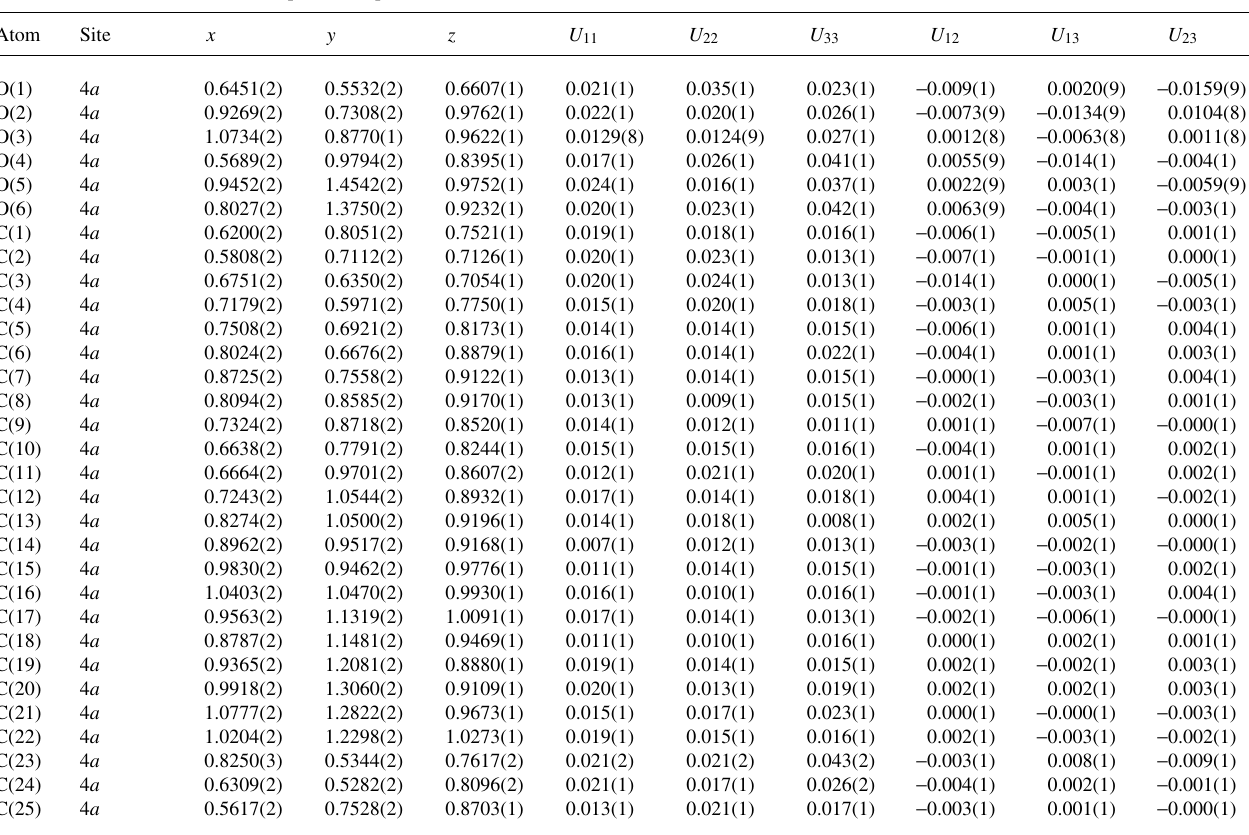
Table 3. Atomic coordinates and displacement parameters (in Å 2 ) .